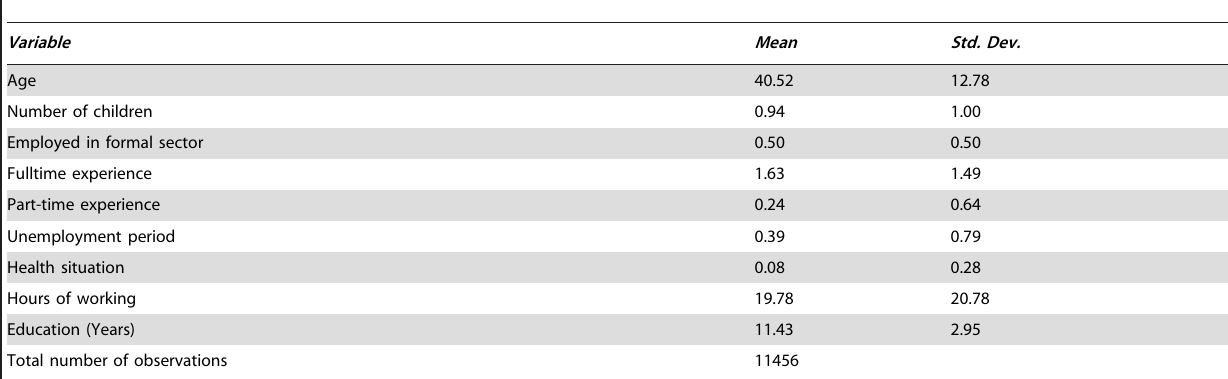
Table 1. Basic Descriptive Statistics of Employment